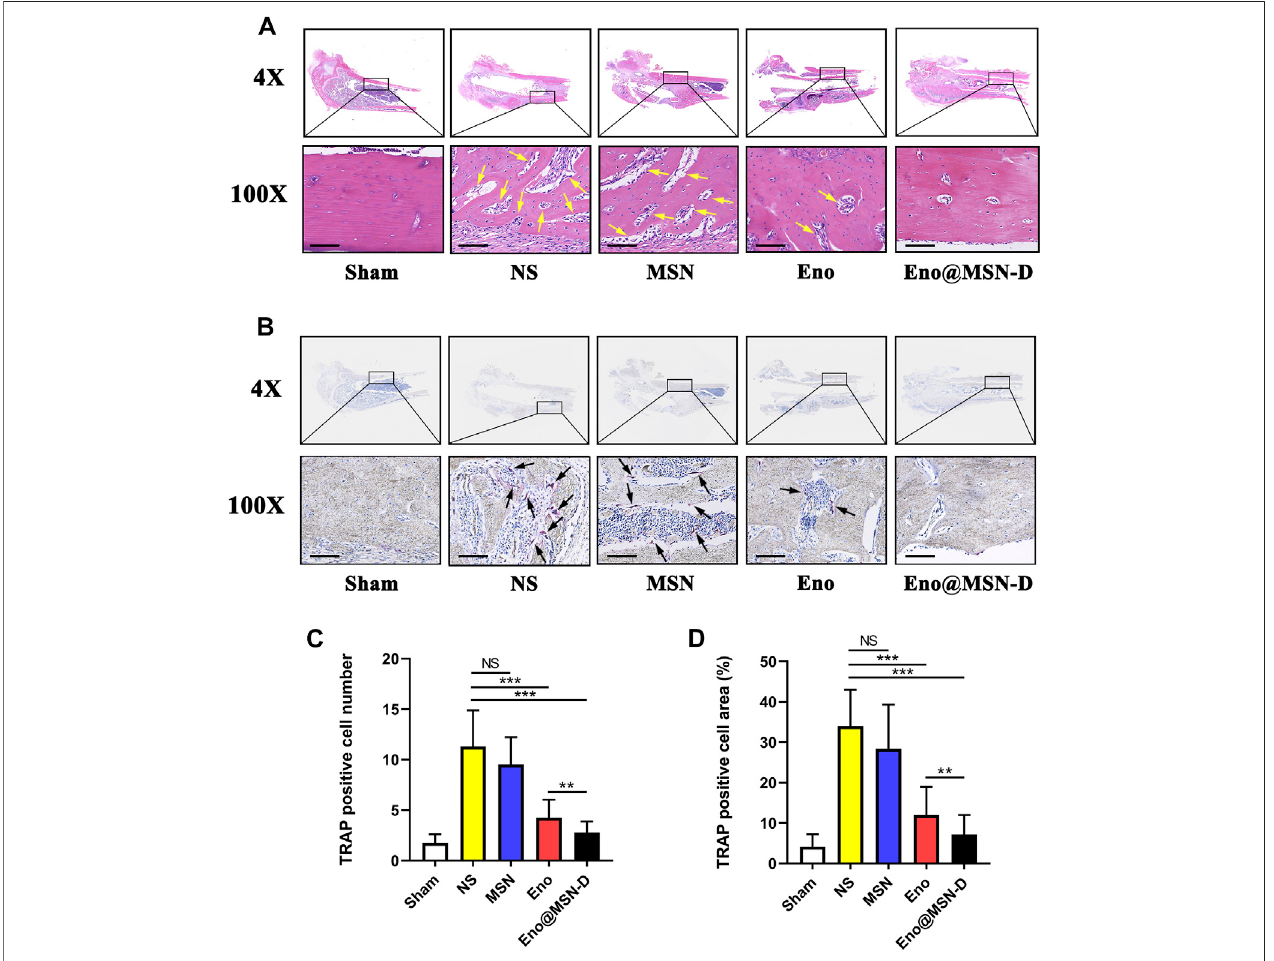
FIGURE 10 | (A) The representative images of HE staining of the middle part of the femur. Yellow arrows indicate dimensional intracortical abscesses or in fl ammatory cells. (B) The representative images of TRAP staining of the middle part of the femur. Black arrows represent osteoclasts. (C) Statistical graph of the number of osteoclasts in each fi eld of view. (D) Statistical graph of the area of osteoclasts in each fi eld of view. All scale bars (cid:1) 200 μ